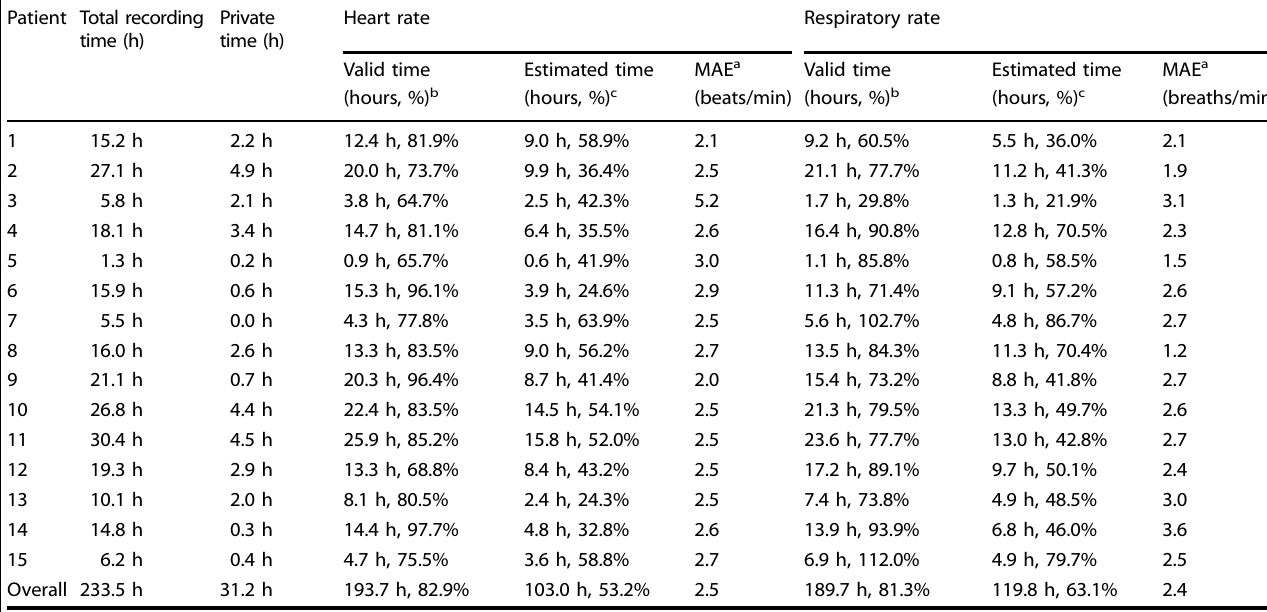
Table 2. Summary of vital-sign estimation results for all recording sessions. Patient Total recording time (h)